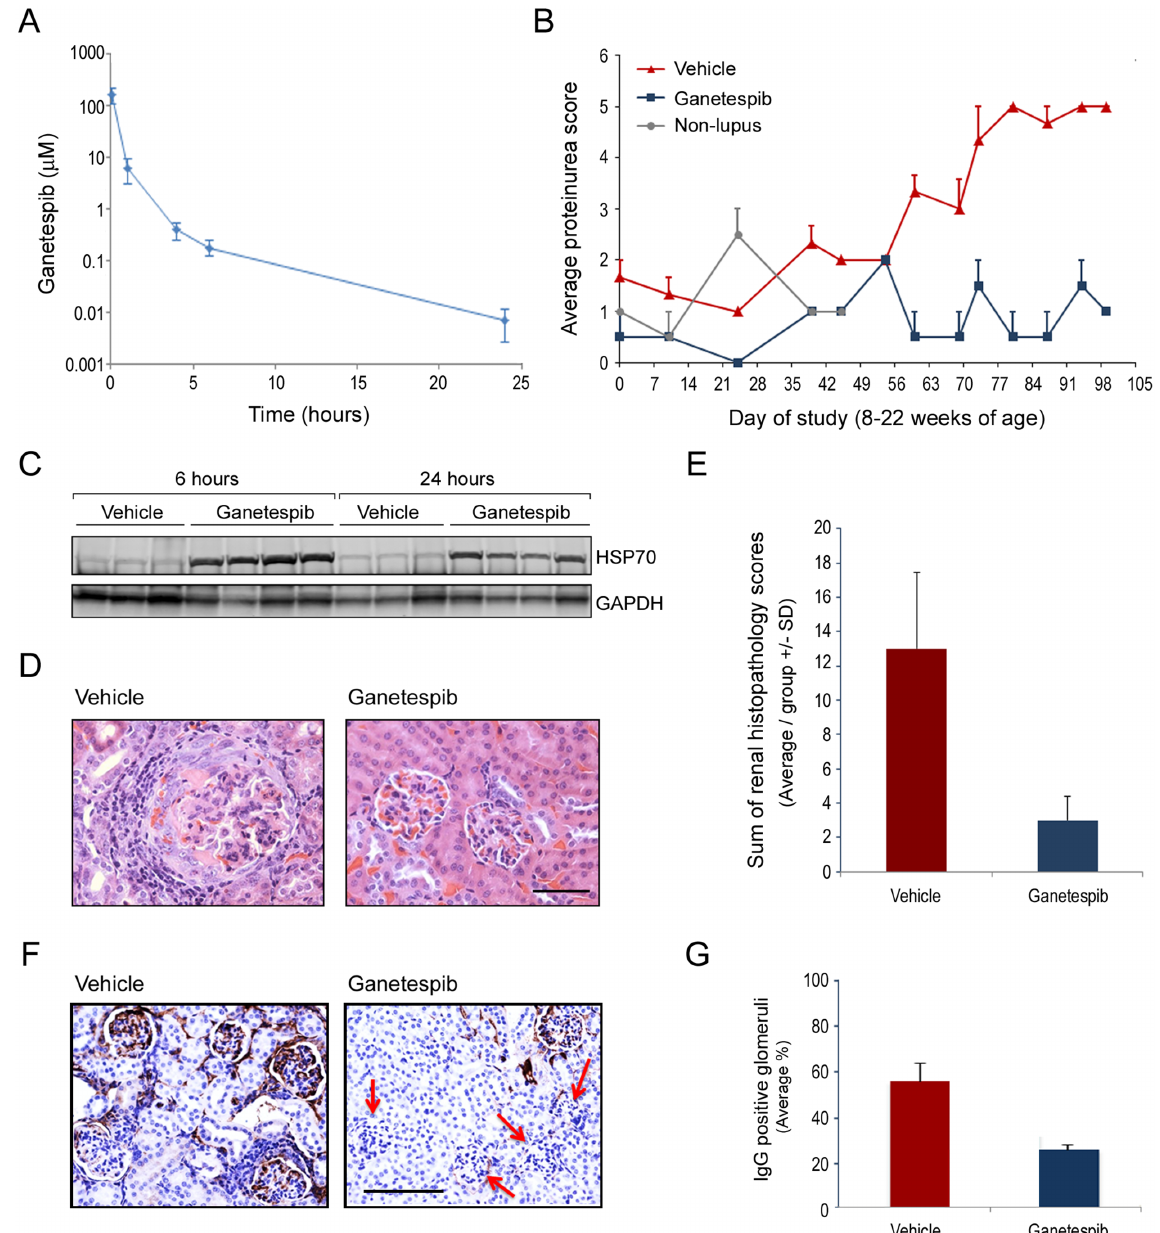
Fig 1. Ganetespib prevents the development of renal damage in a pilot prophylactic dosing study. (A) Mean pharmacokinetic plasma concentration- time profile after i.v. administration of ganetespib to MRL/lpr mice. Ganetespib was dosed at 50 mg/kg twice weekly and samples were taken after the second dose. Data represent mean ± SD (n = 3). (B) Average proteinuria scores ( ± SE) are plotted for vehicle and ganetespib-treated mice over the time course of the study. Average proteinuria scores for non-lupus parental strain (MRL/mp) mice from 8 – 15 weeks of age are included for comparison. (C) HSP70 induction as a pharmacodynamic marker of ganetespib activity in kidneys from drug-treated animals. Kidneys were harvested at 6 and 24 hours following the second intra-weekly dose of ganetespib (or vehicle) and lysates immunoblotted for HSP70 expression. GAPDH included as a loading control. Each lane represents renal tissue from an individual animal. (D) Representative H&E stained renal histopathology showing extensive chronic inflammation and thickening of the basement membrane with crescent formation in the glomerulus of a vehicle-treated mouse ( left panel ). In contrast, the kidneys of a ganetespib-treated animal showed no evident pathologic changes ( right panel ). Original magnification, 40X; scale bar represents 50 μ m. (E) To evaluate total lupus-related renal damage 7 primary characteristics of GN (glomerular capillary deposits, hypercellularity, necrosis, tubular atrophy, intratubular casts, interstitial chronic inflammation, and fibrosis) were scored for each animal and summed for a composite disease score. The average summed pathology scores for each treatment group are plotted. (E) Representative IgG immunohistochemical staining of renal tissues harvested from vehicle- and ganetespib-treated animals at 22 weeks of age. Red arrows highlight the marked reduction in glomerular IgG deposition seen following HSP90 inhibitor treatment. Original magnification 20X: scale bar represents 100 μ m. (F) Quantification of IgG glomerular immunoreactivity observed in vehicle and drug treated animals.